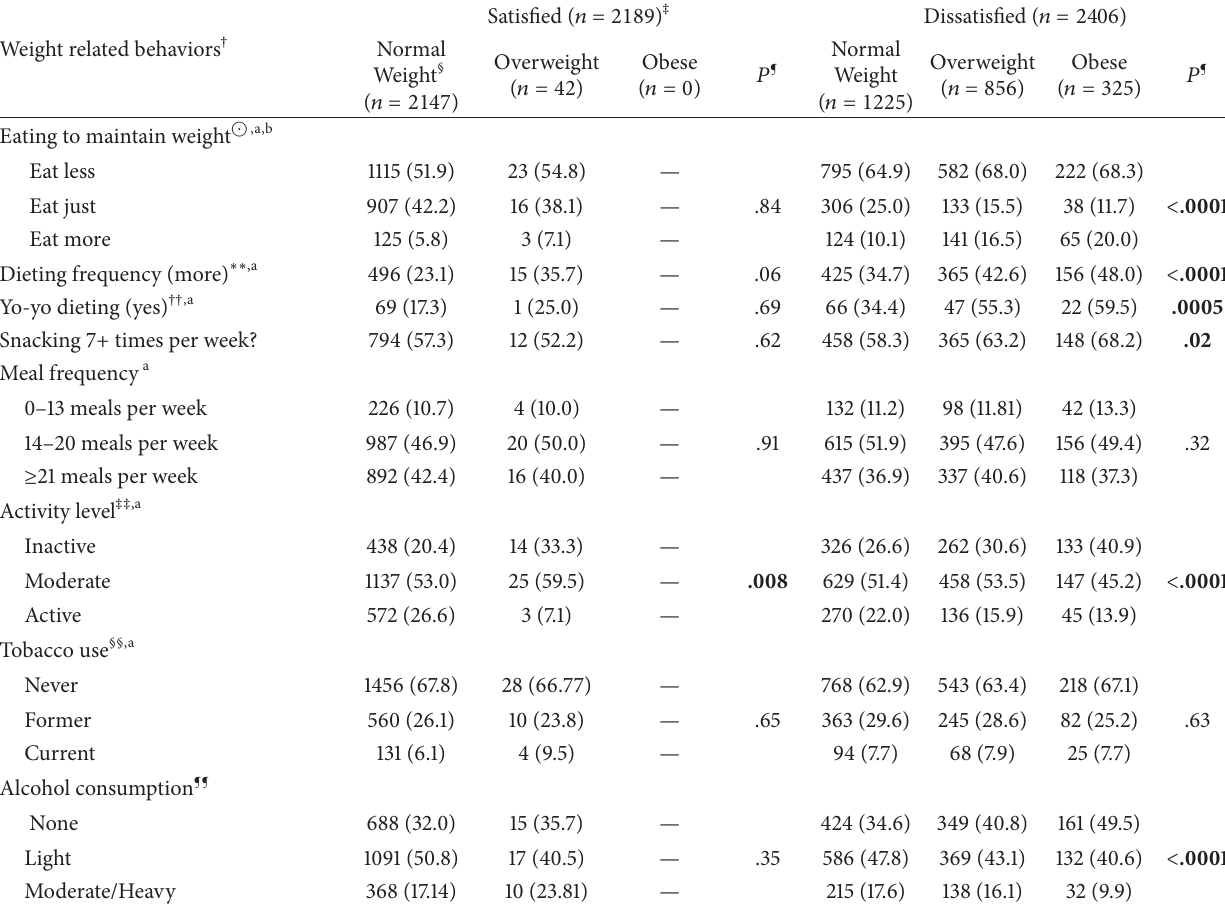
Table 4: Relationships between body weight satisfaction by overweight status and weight-related health behaviors, Aerobics Center Longitudinal Study, 1987–2002: women ( 𝑛 = 4595 ) ∗